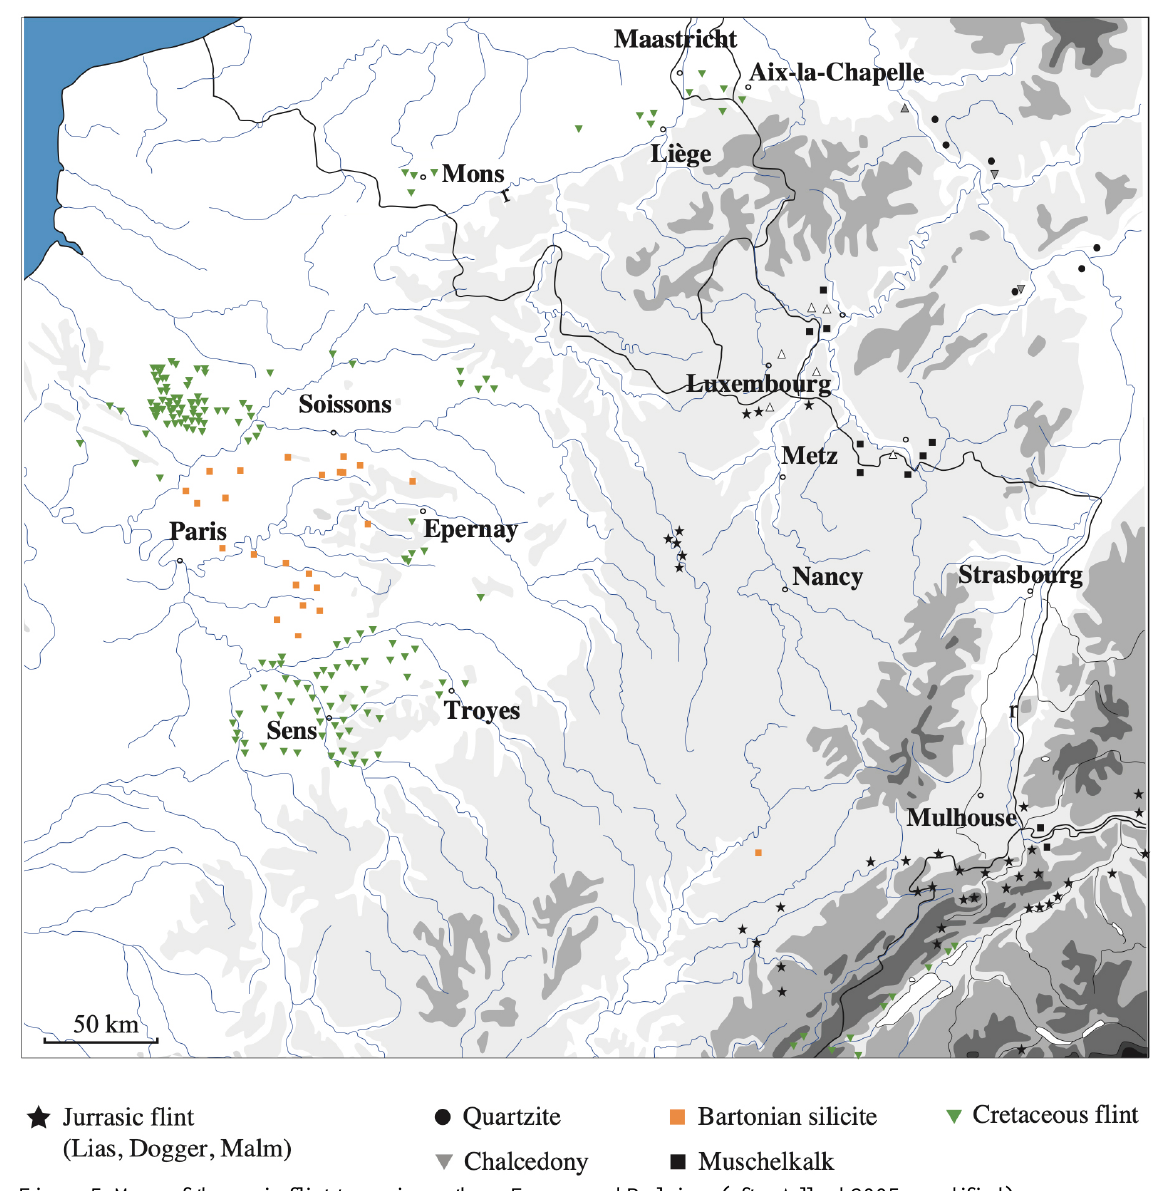
Figure 5. Map of the main flint types in northern France and Belgium (after Allard 2005,